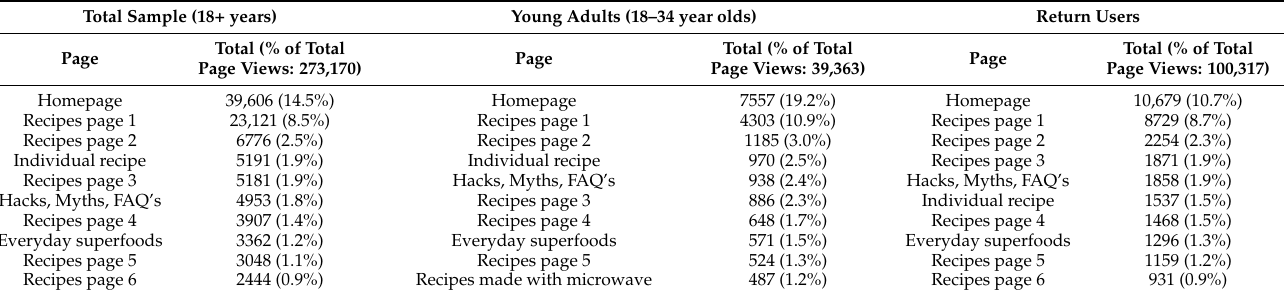
Table 5. Top ten page views for total sample, young adults and for return